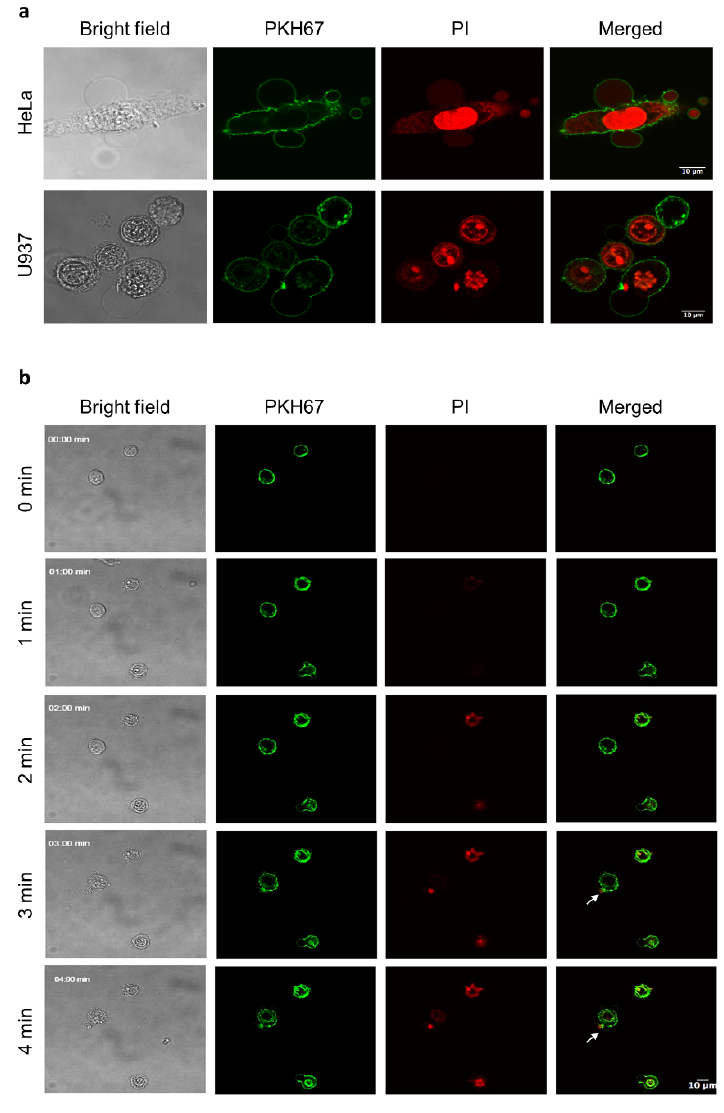
Figure 2. Kinetics of HBD-2-induced tumour cell death. ( a ) CLSM of HBD-2 (25 µ M) treated HeLa and U937 cells, in the presence of PI and membrane stain PKH67. Images were taken 5 min post addition of HBD-2. ( b ) CLSM of HBD-2 (25 μ M) on the kinetics of U937 cell permeabilisation. PI-positive staining and membrane blebbing occur 1 min post-HBD-2 addition, followed by the release of intracellular content (indicated by white arrows). Data representatives of three independent experiments. Scale bars represent 10 μ m.